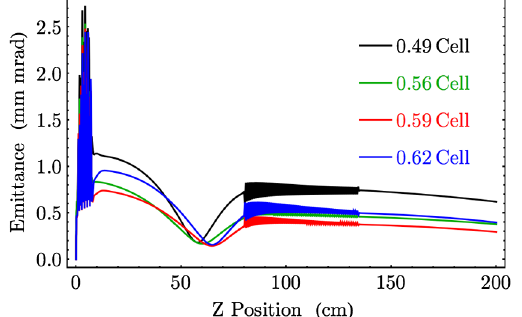
FIG. 2. Normalized emittance of a 250 pC bunch along the photoinjector for rf guns having different initial cell